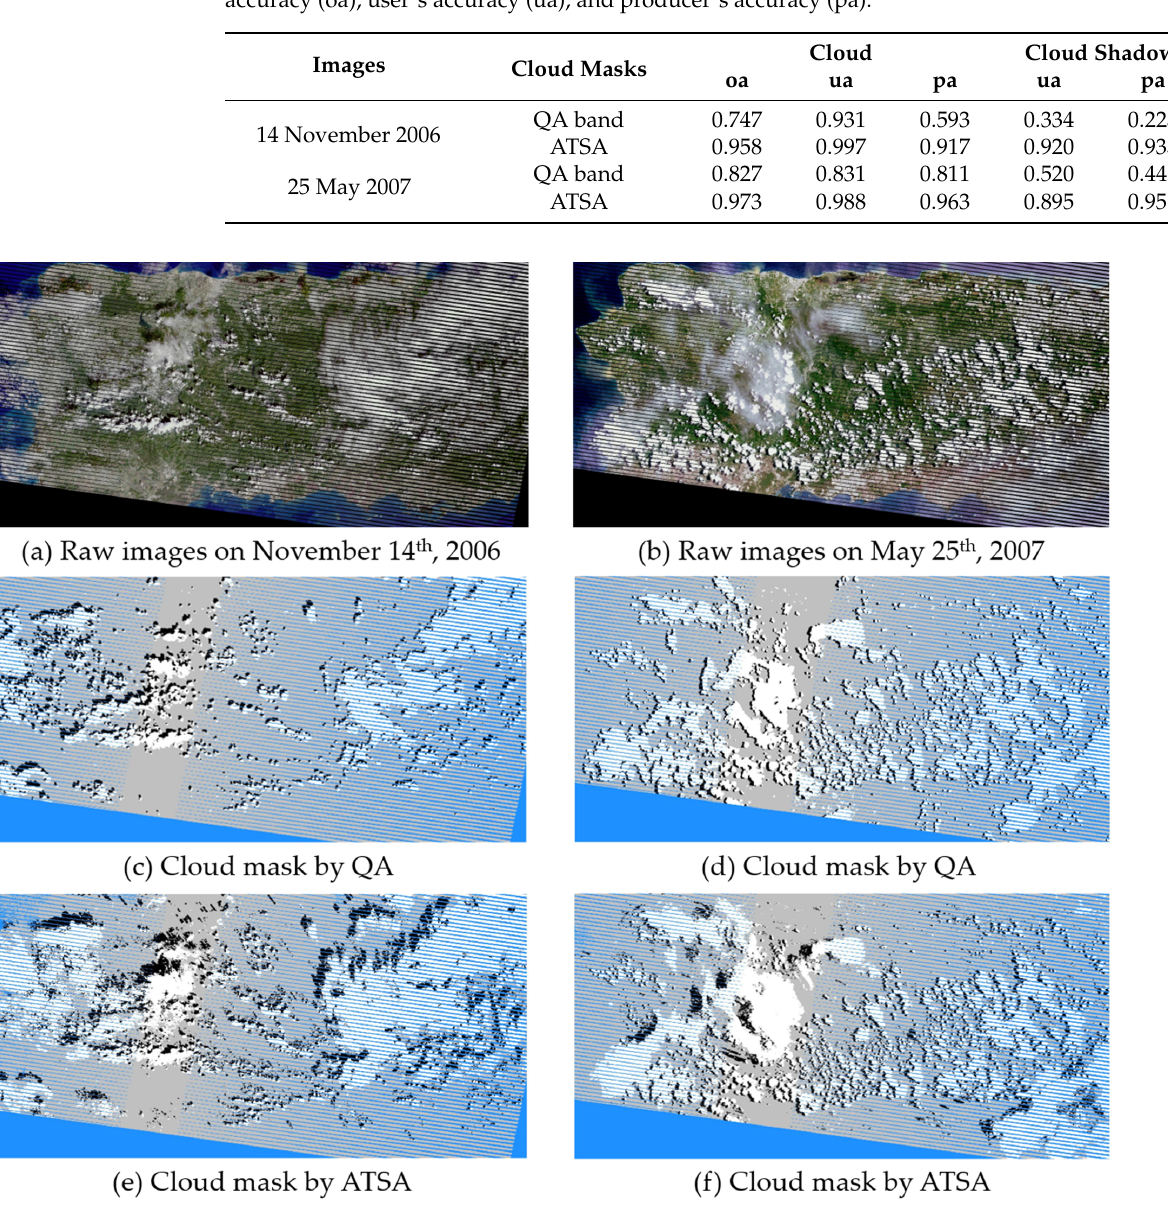
Table 3. Accuracy assessment of cloud and cloud shadow masks of two images in Figure 8: overall